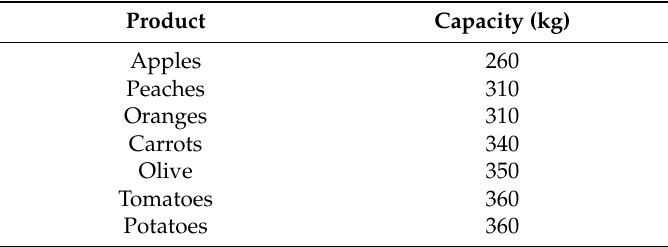
Table 6. Mass capacity of the selected fruit bin.